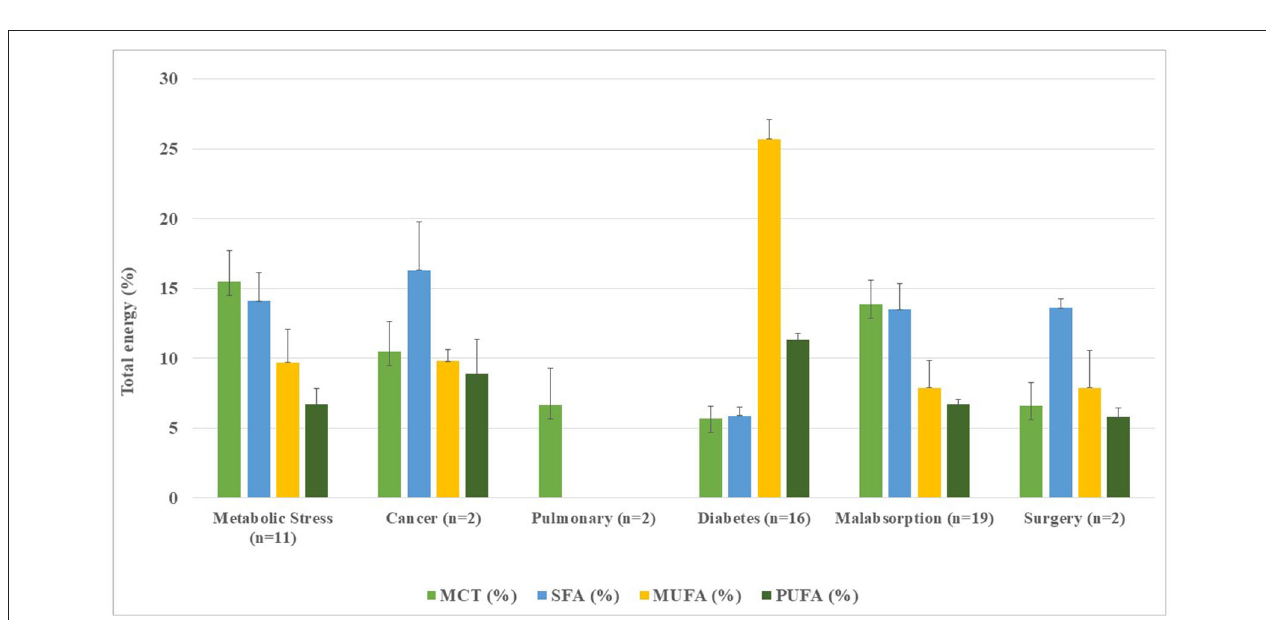
carbohydrate contents were found in hypercaloric